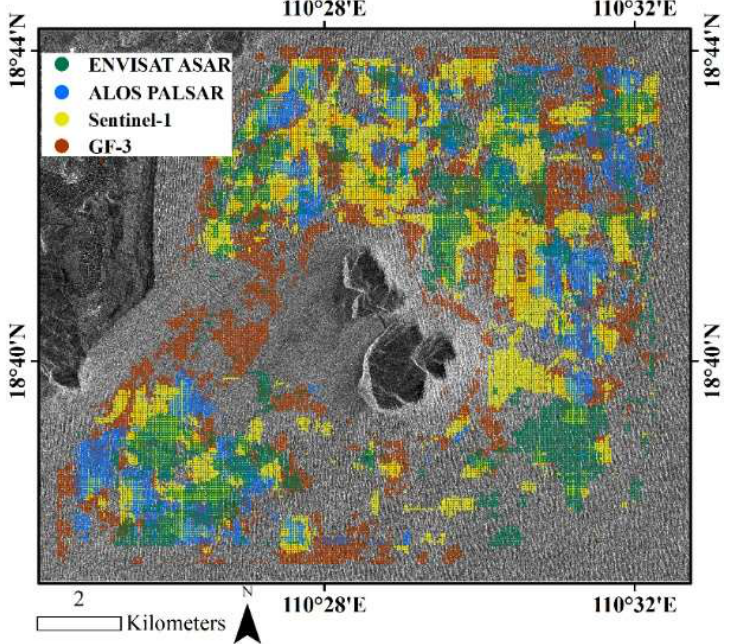
Figure 8. Integrated schematic of valid water depth, the green, blue, yellow, brown dots present the locations of valid water depth from ENVISAT ASAR, ALOS PALSAR, Sentinel-1, GF-3 images, respectively.